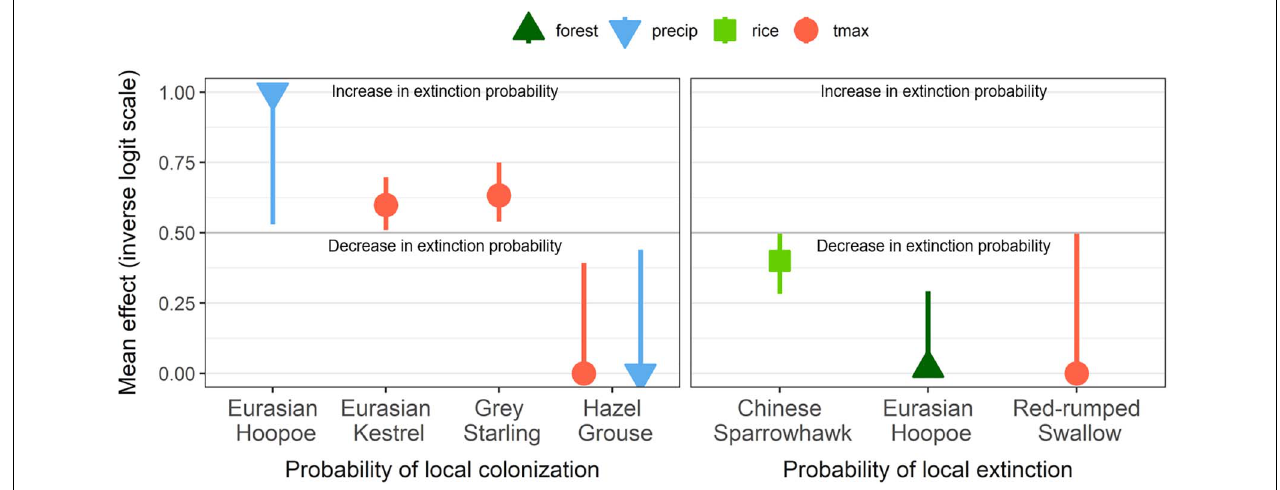
FIGURE 3 | Effects of landscape and climate covariates on dynamic parameters. Mean and confidence interval (95%) above 0.5 indicate an increase in the probability of colonization and extinction per unit increase in covariate, and values below 0.5 indicate a decrease in colonization and extinction per unit change in each covariate.